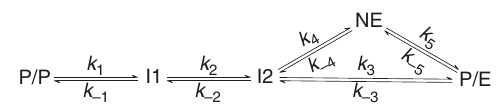
Fig. 3 Kinetic scheme implicated by simulations. Transitions between I1 and P/E may occur via I2, or I2